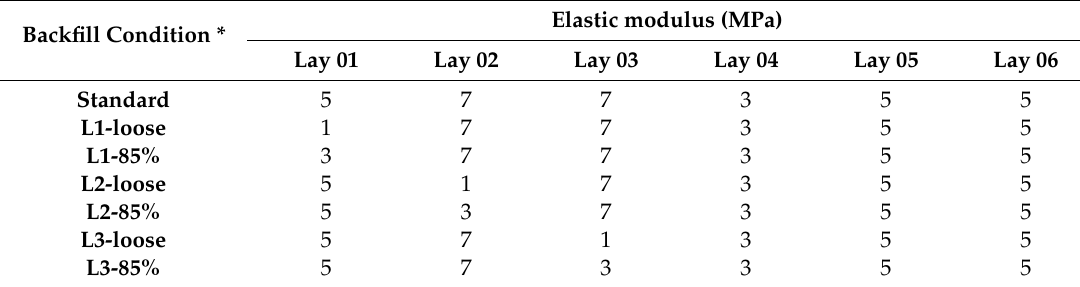
Table 6. Simulation backfill compaction conditions.